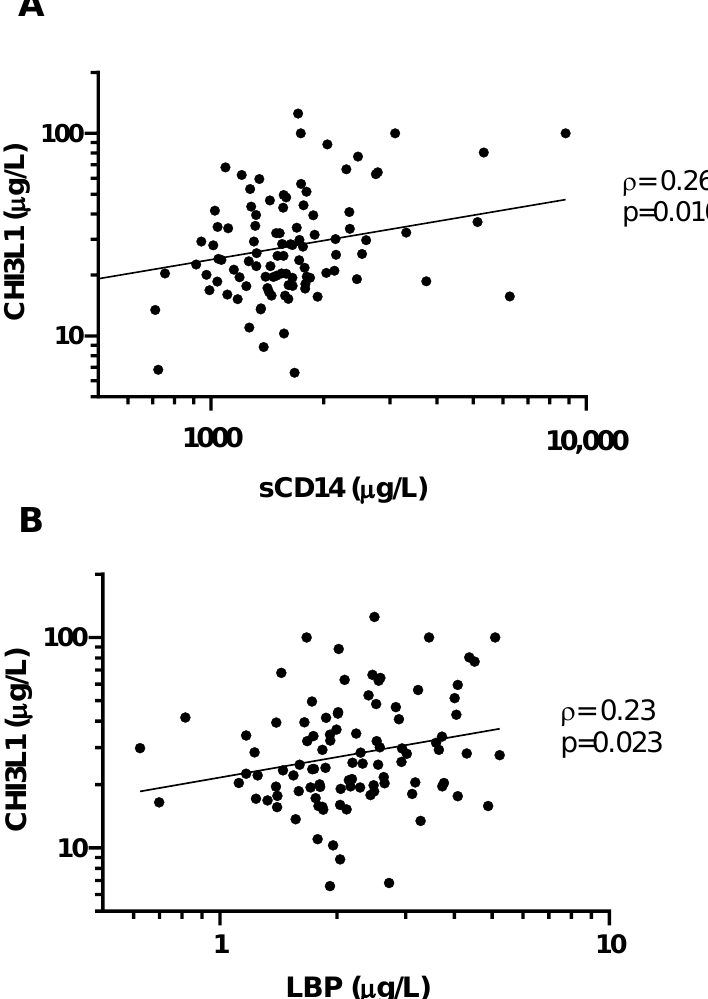
Figure 3. CHI3L1 is correlated with markers of microbial translocation. CHI3L1 was directly correlated with ( A ) sCD14 ( ρ = 0.26, p = 0.010), and ( B ) LBP ( ρ = 0.23, p = 0.023). Concentrations of all biomarkers were measured with an ELISA. Non-parametric Spearman’s rank correlation coefficient ( ρ ) and the associated p -values are indicated.